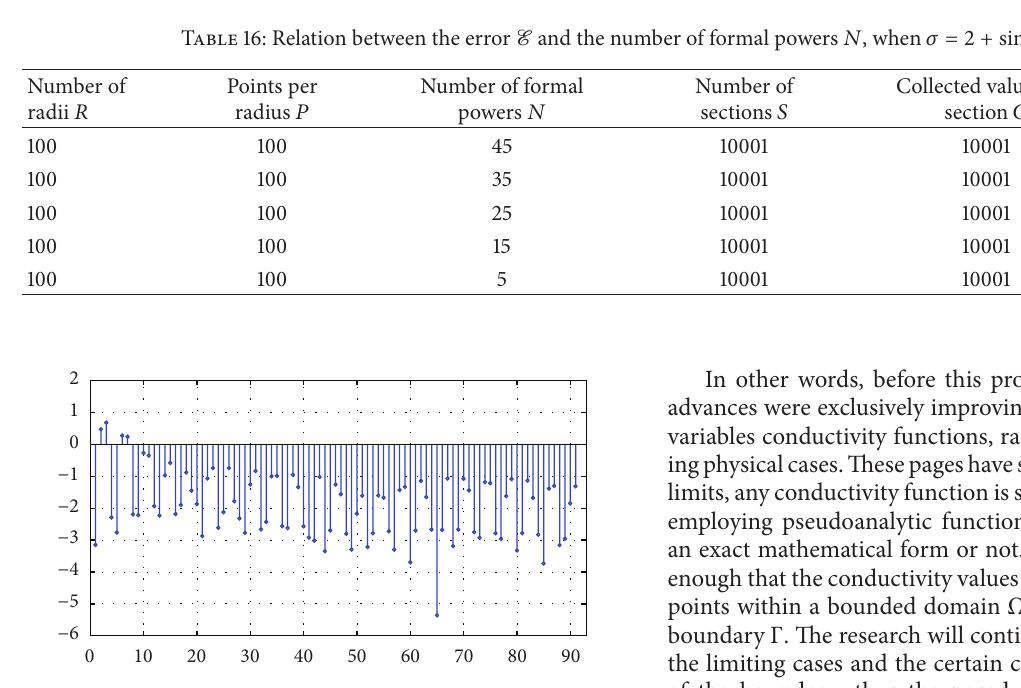
Figure 9: Absolute values of the coefficients 𝛼 𝑛 employed for approaching the boundary condition 𝑢| Γ = (1/3)(𝑥 + 𝑦) 3 + 0.1(𝑥 + 𝑦) , utilizing the base elements {𝑢 ity function 𝜎 = ((𝑥 + 𝑦) 2 + 0.1)